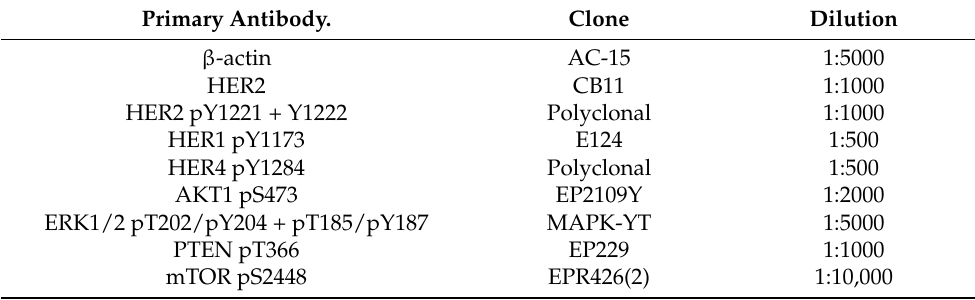
Table 2. Primary antibodies and their dilutions used for chemoluminescence analysis. Primary Antibody.